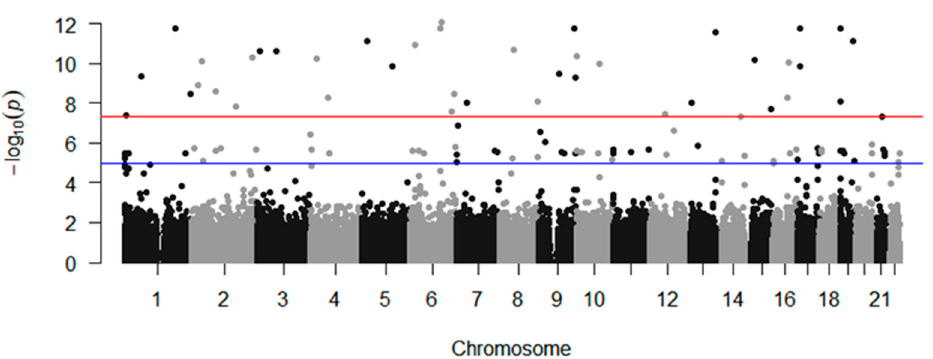
Figure 1. Manhattan plot for genome wide association study (GWAS) data from the Korean female population, showing − log10 ( p -values) from GWAS and imputation analysis plotted against the chromosome position. Each color represents a different chromosome. The lower line indicates the suggested association threshold ( p = 1.0 × 10 − 5 ) while the upper line indicates the genome-wide significance threshold ( p = 5.0 × 10 − 8 ).